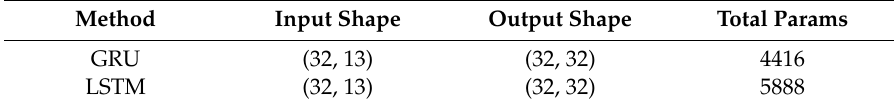
Table 4. Comparison of GRU and LSTM model in the number of parameters.